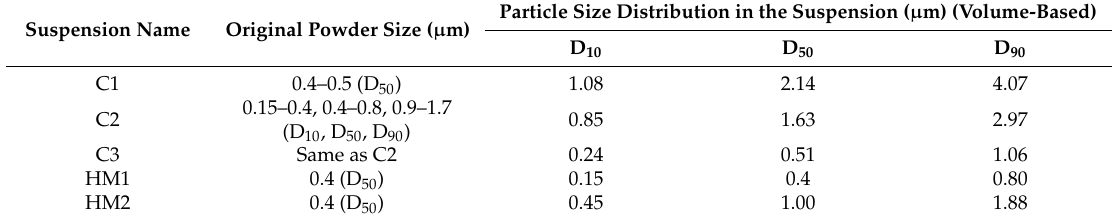
Table 4. Particle size distribution in original powder and in suspensions.